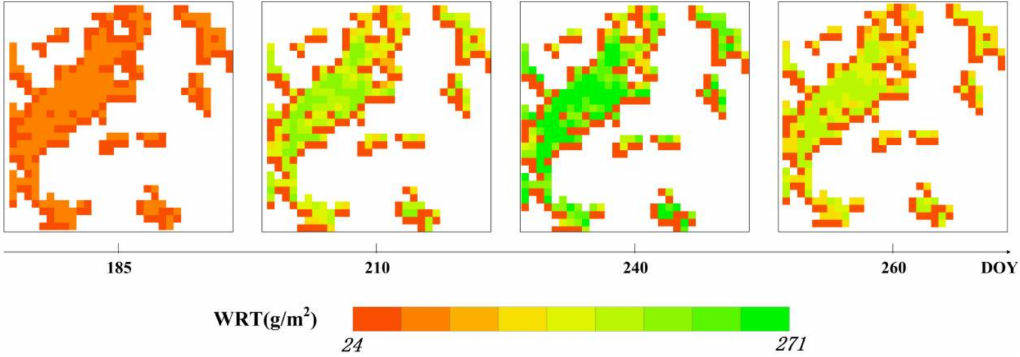
Figure 11. Spatial distribution of heavy metal stress level represented by continuous simulation of the WRT in study area